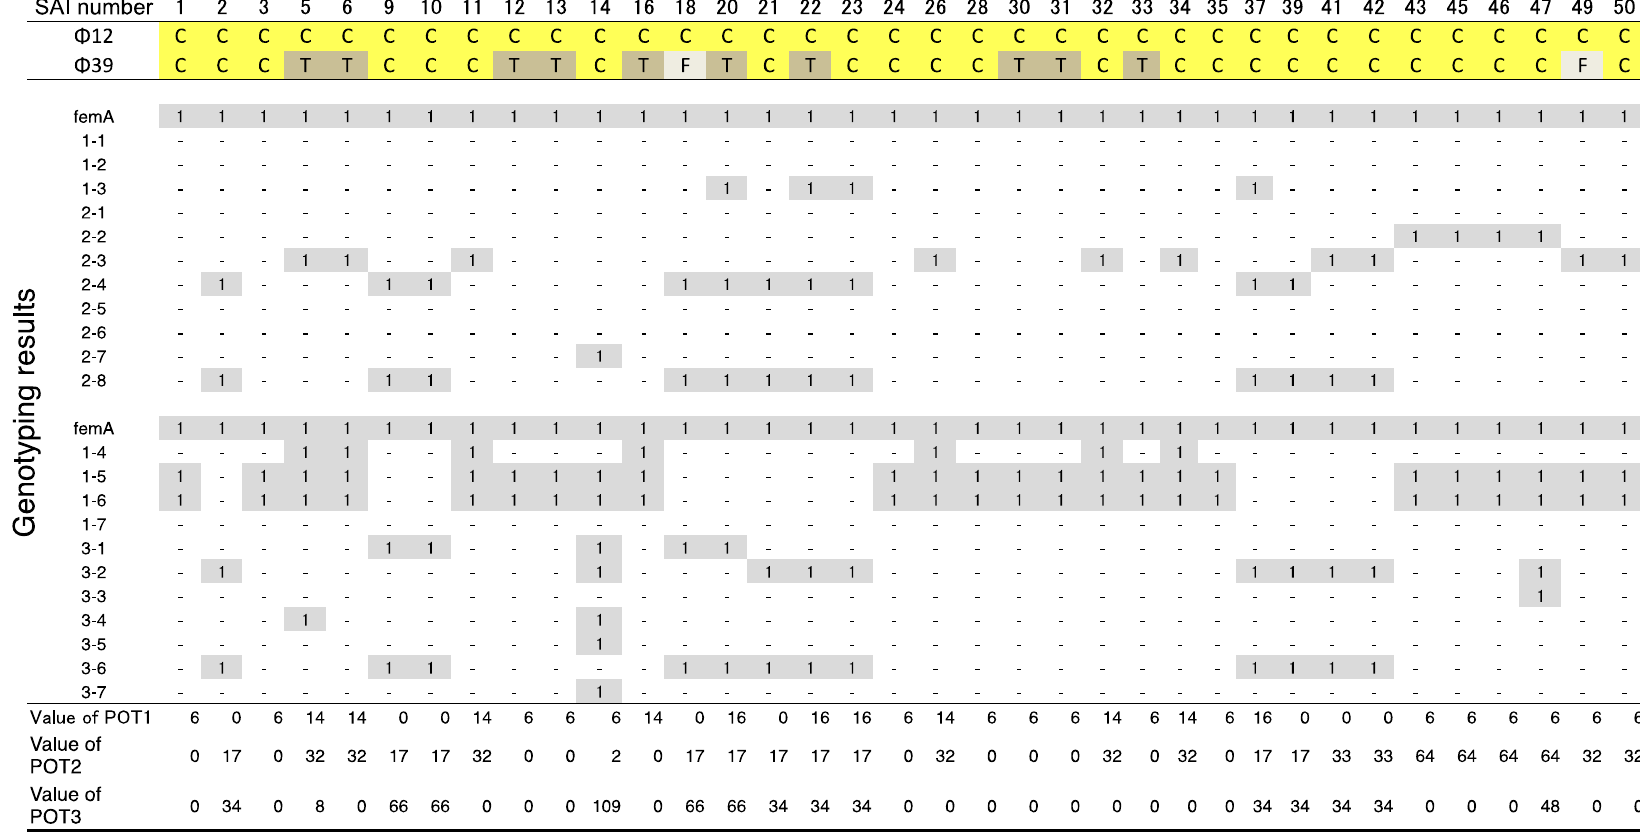
Table 3. Host ranges of S. aureus phages, Φ SA012 and Φ SA039, against S. aureus